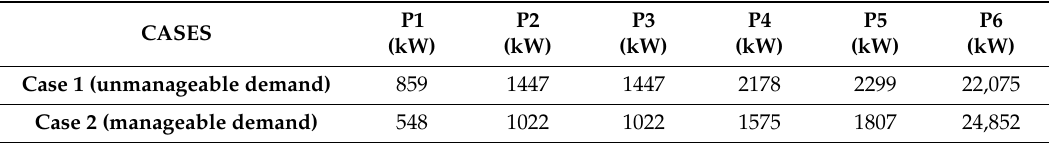
Table 7. Comparison of optimal contracted demand in each pricing period with and without intraday demand